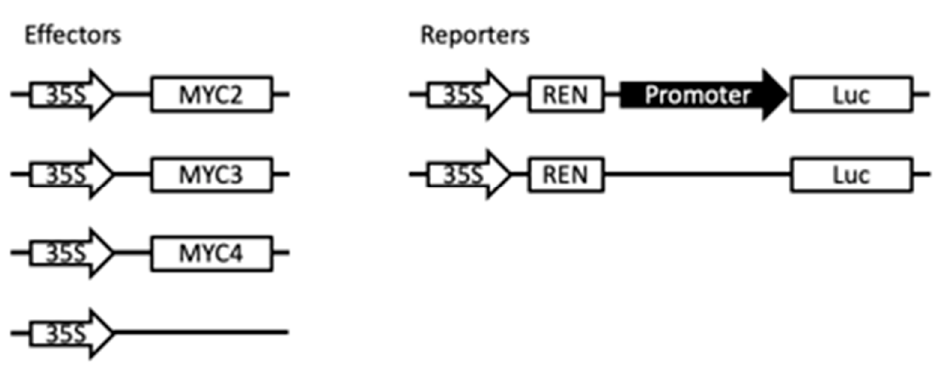
Figure A6. Detection of protoplasts MYC-like transcription factors regulate the activity of the paclitaxel biosynthetic pathway gene promoter. The plasmid overexpressing the MYC transcription factor was used as the e ff ector, the fluorescent protein LUC regulated by the paclitaxel biosynthesis pathway gene promoter was used as the reporter gene, and the overexpressed red fluorescent protein REN was used as the internal reference to be transferred into the Arabidopsis protoplasts. The ratio between the fluorescent signals. Empty plasmid was used as a negative control.